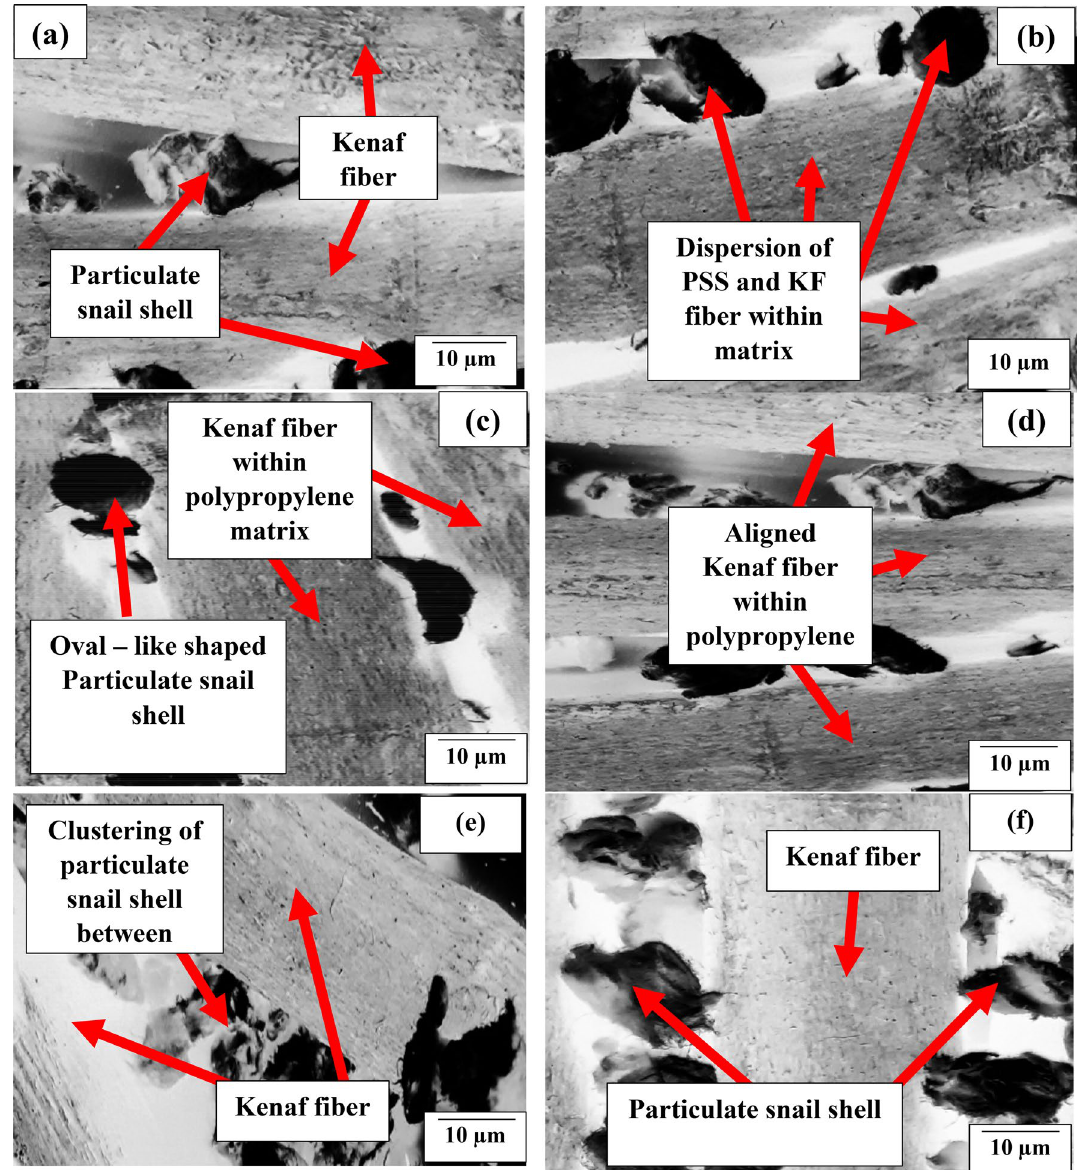
Figure 3. Microstructural image of polypropylene-PSS/KF composites developed, ( a – d ) reflects the images of mix 2 composites; ( e – h ) show the mix 5 composites containing 5 wt% of the particulate; ( i – l ) present morphological representation of the mix 10 composite prepared with 10 wt%